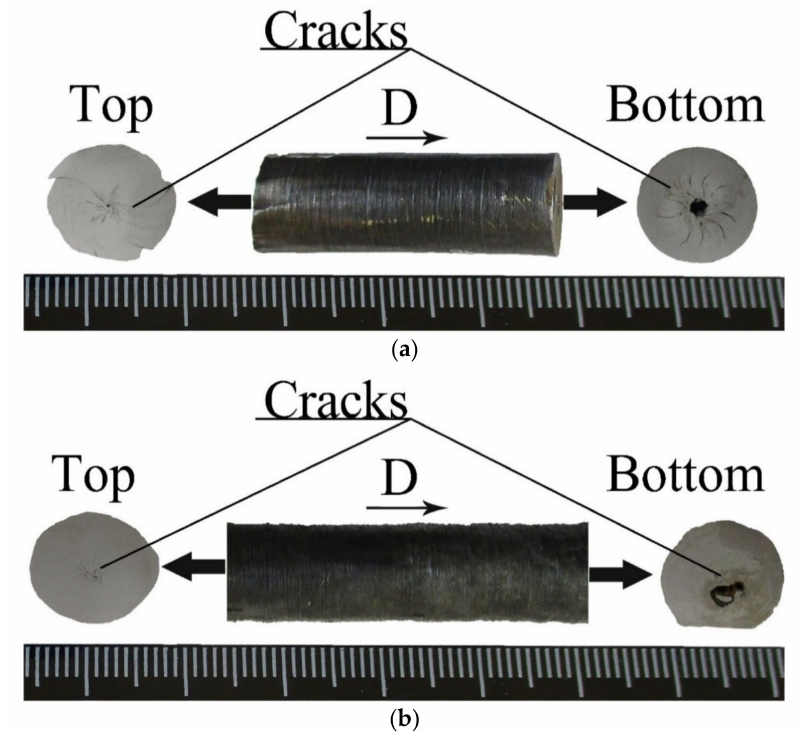
Figure 5. Photograph of segment I: ( a ) ampoule No. 1; ( b ) ampoule No.